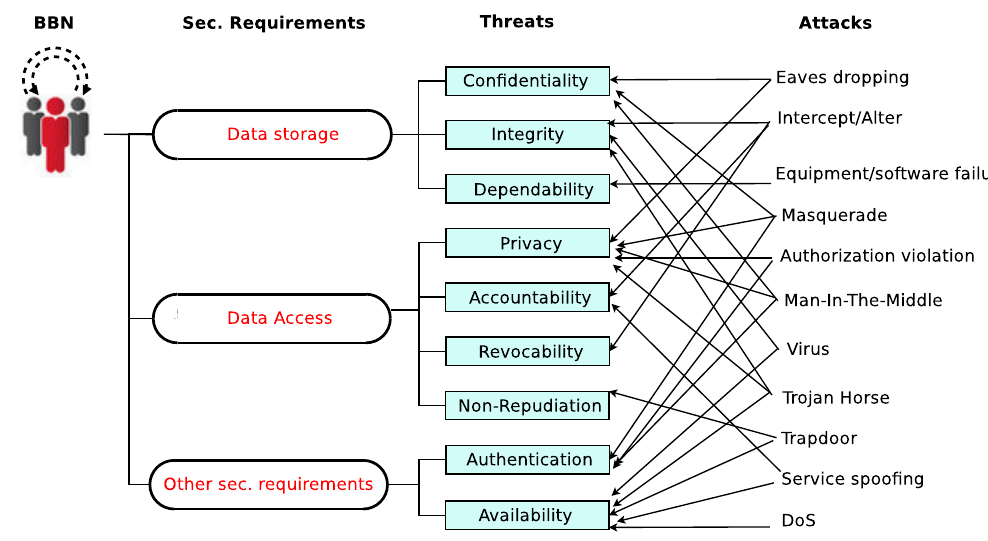
Figure 6. Major security requirements in